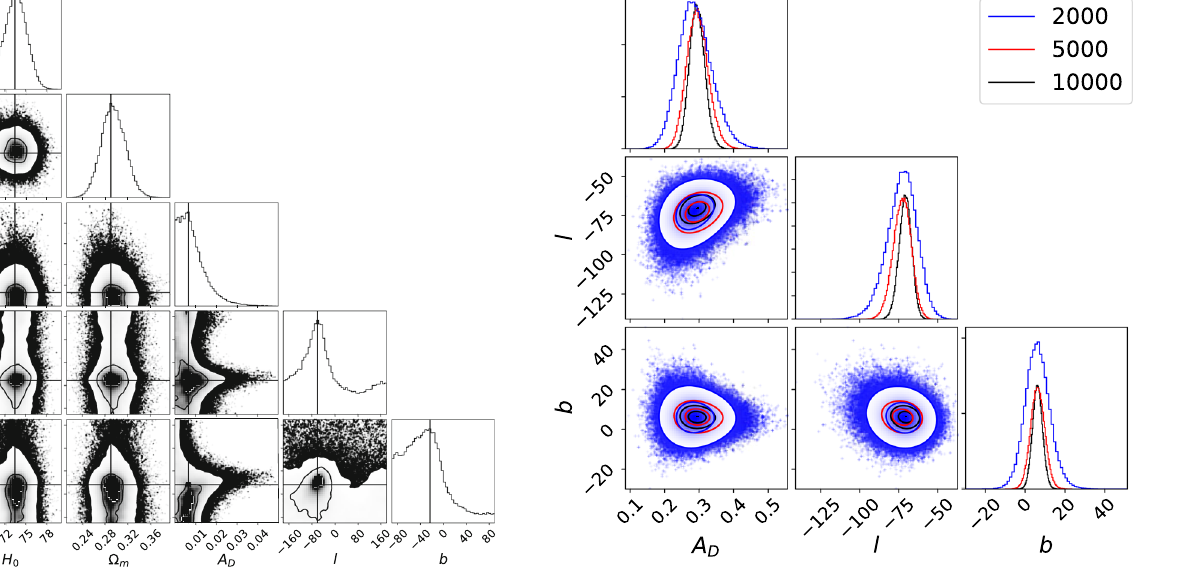
Fig. 4 The marginalized posterior distribution of the parameters in the Finslerian cosmological model with the combination of 2015 quasar compilation, Pantheon sample, and six gravitationally lensed quasars. The horizontal and vertical solid black lines denote the maximum of 1-dimensional marginalized posteriors